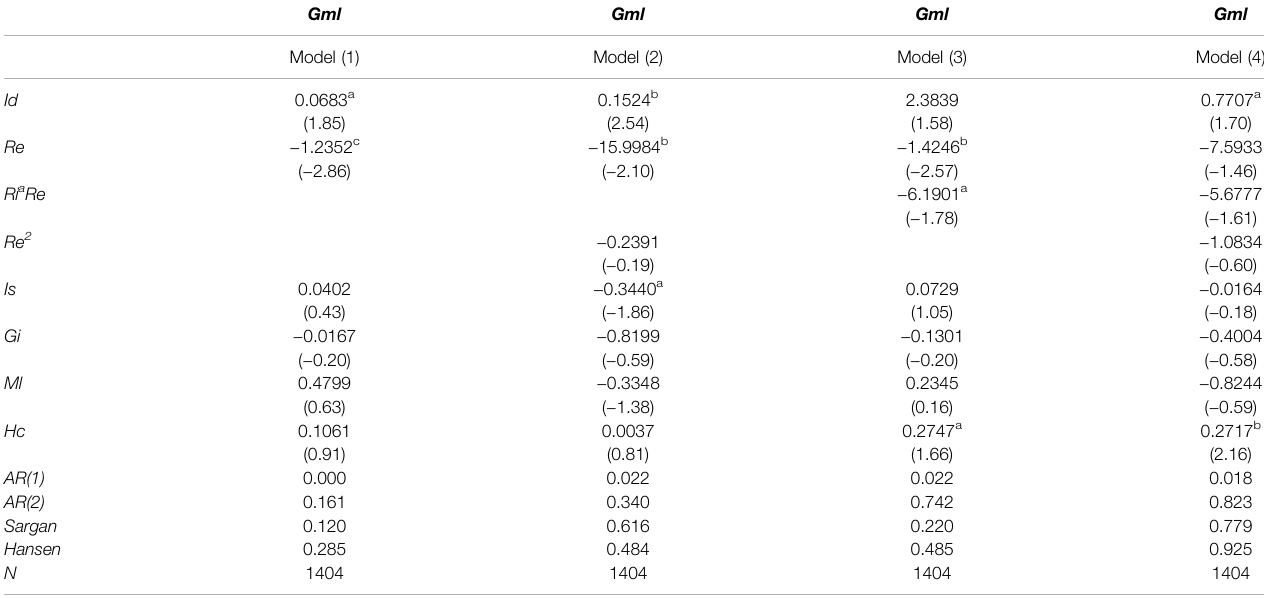
TABLE 3 | Benchmark regression